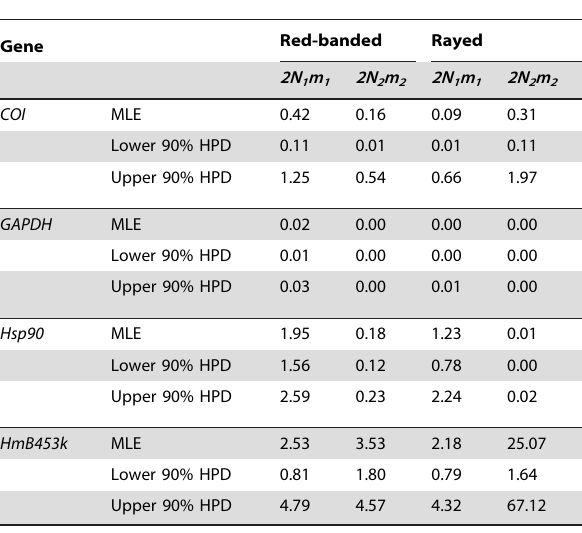
Table 2. Rates of interspecies introgression between H. melpomene , H. heurippa , and H. timareta .